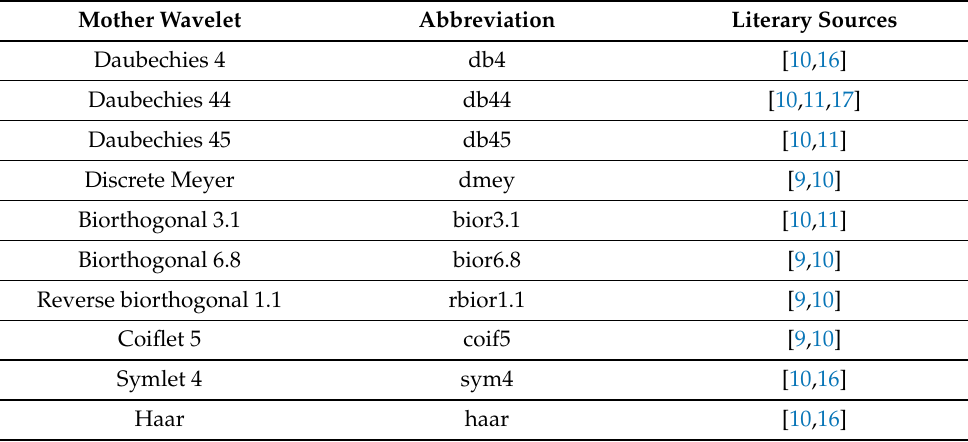
Table 1. Mother wavelet used in the screening algorithm. Mother Wavelet Abbreviation Literary Sources Daubechies 4